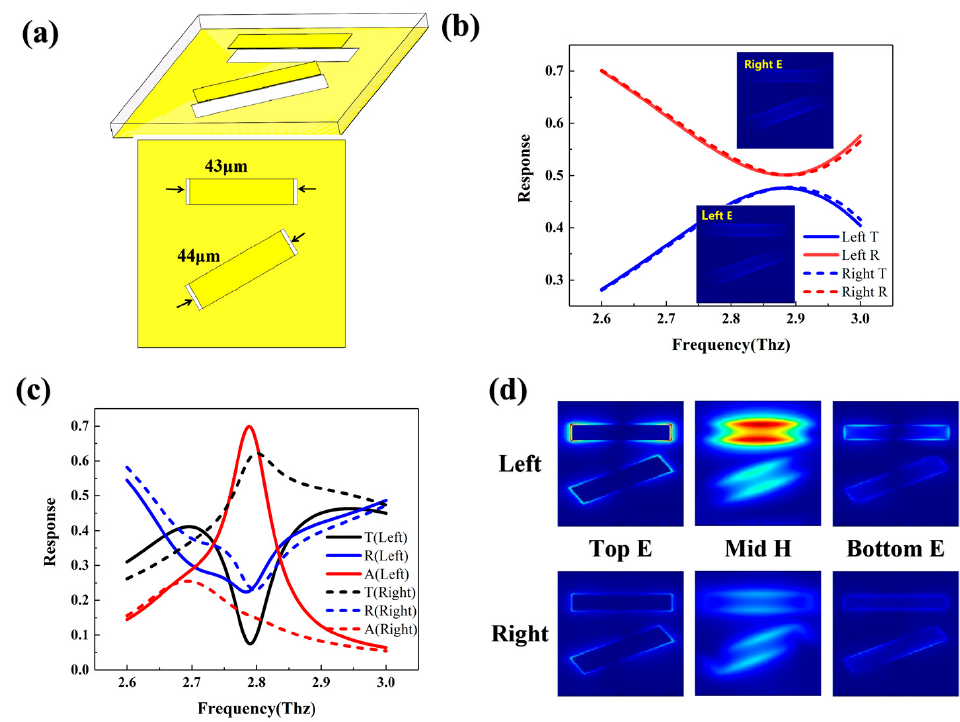
Figure 10. ( a ) Schematic diagram of the chiral composite structure. The dimensions of the top struc- ture and medium are the same as the basic structure. The lengths of the rectangular holes are 43 µ m and 44 µ m. ( b ) The transmission efficiency and the corresponding electric field of the rectangular hole structure for left and right-handed polarized light. ( c ) Response spectrum (absorption, reflectivity, and transmission) of left and right-handed polarized light. ( d ) Electric and magnetic field distribution at the absorption and transmission peaks (electric field at the top and bottom structure in the xy plane, and magnetic field in the middle xy section of the medium).